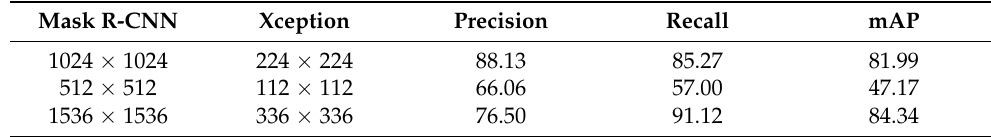
Table 10. Results of varying image resolutions.